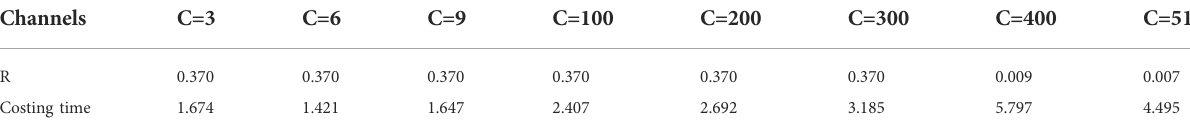
TABLE 2 Correlation and costing time analysis of the IMFs with the different channels for the noisy data in Figure 1B.